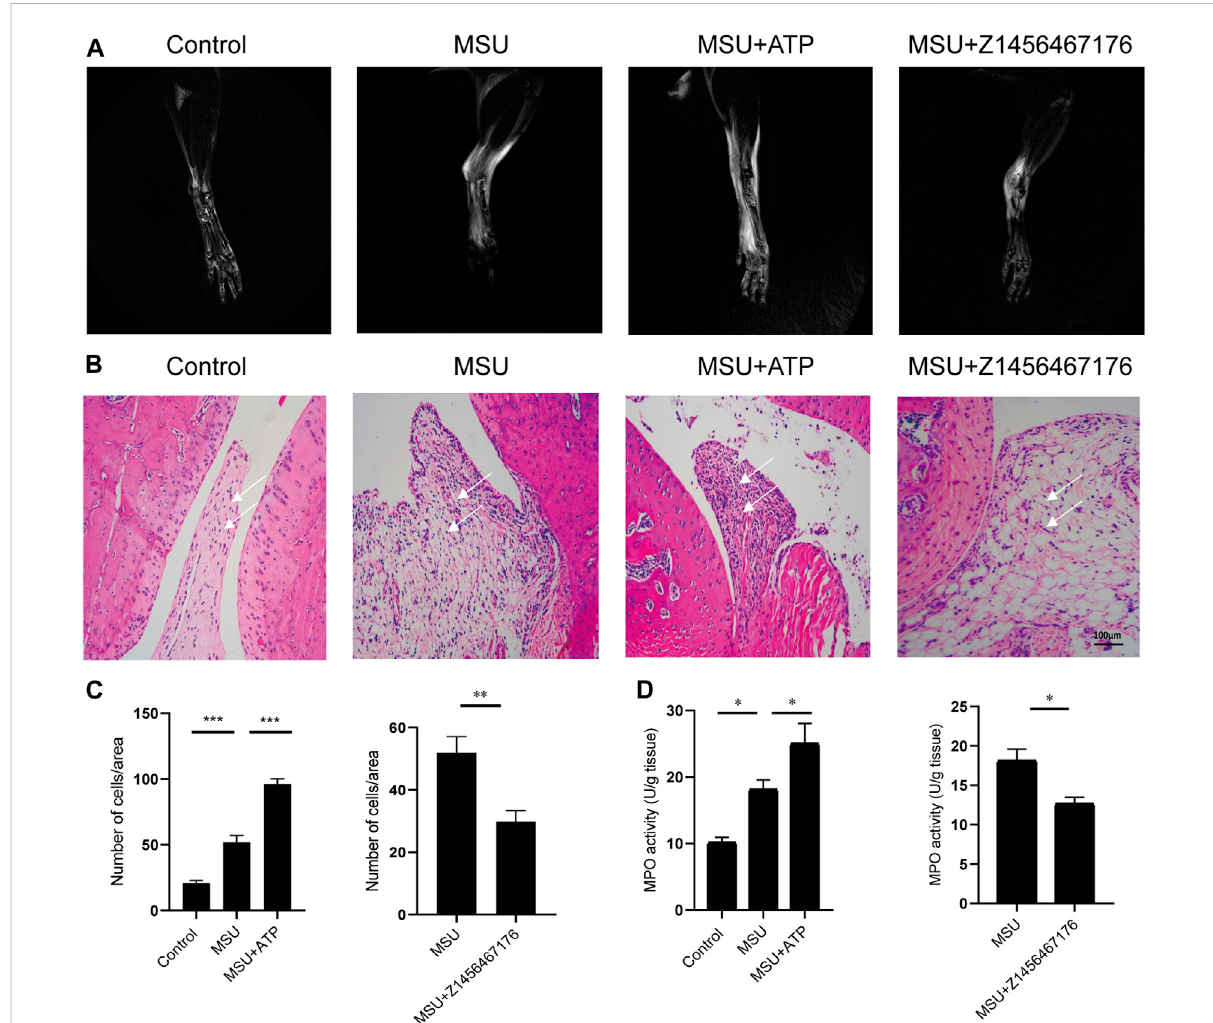
FIGURE. 6 Z1456467176 alleviatesgoutyarthritisinrats. (A) RepresentativeMRIimagesoftherightanklejointofrats. Thewhiteportionre fl ectsthedegree of in fl ammatory edema. (B) Representative images of pathological H&E staining of the right ankle joint of rats (×200). The white arrow points to in fl ammatory cell in fi ltration in the synovial tissue of the ankle joint. (C) Equal-sized areas were taken from each group in (B) for quanti fi cation of in fl ammatory cells. (D) MPO activity of ankle joint homogenates. Data are presented as the means ± S.E.M.s. Statistics were analyzed using the independent samples t test or Dunnett ’ s t test. * p < 0.05; ** p < 0.01; *** p <